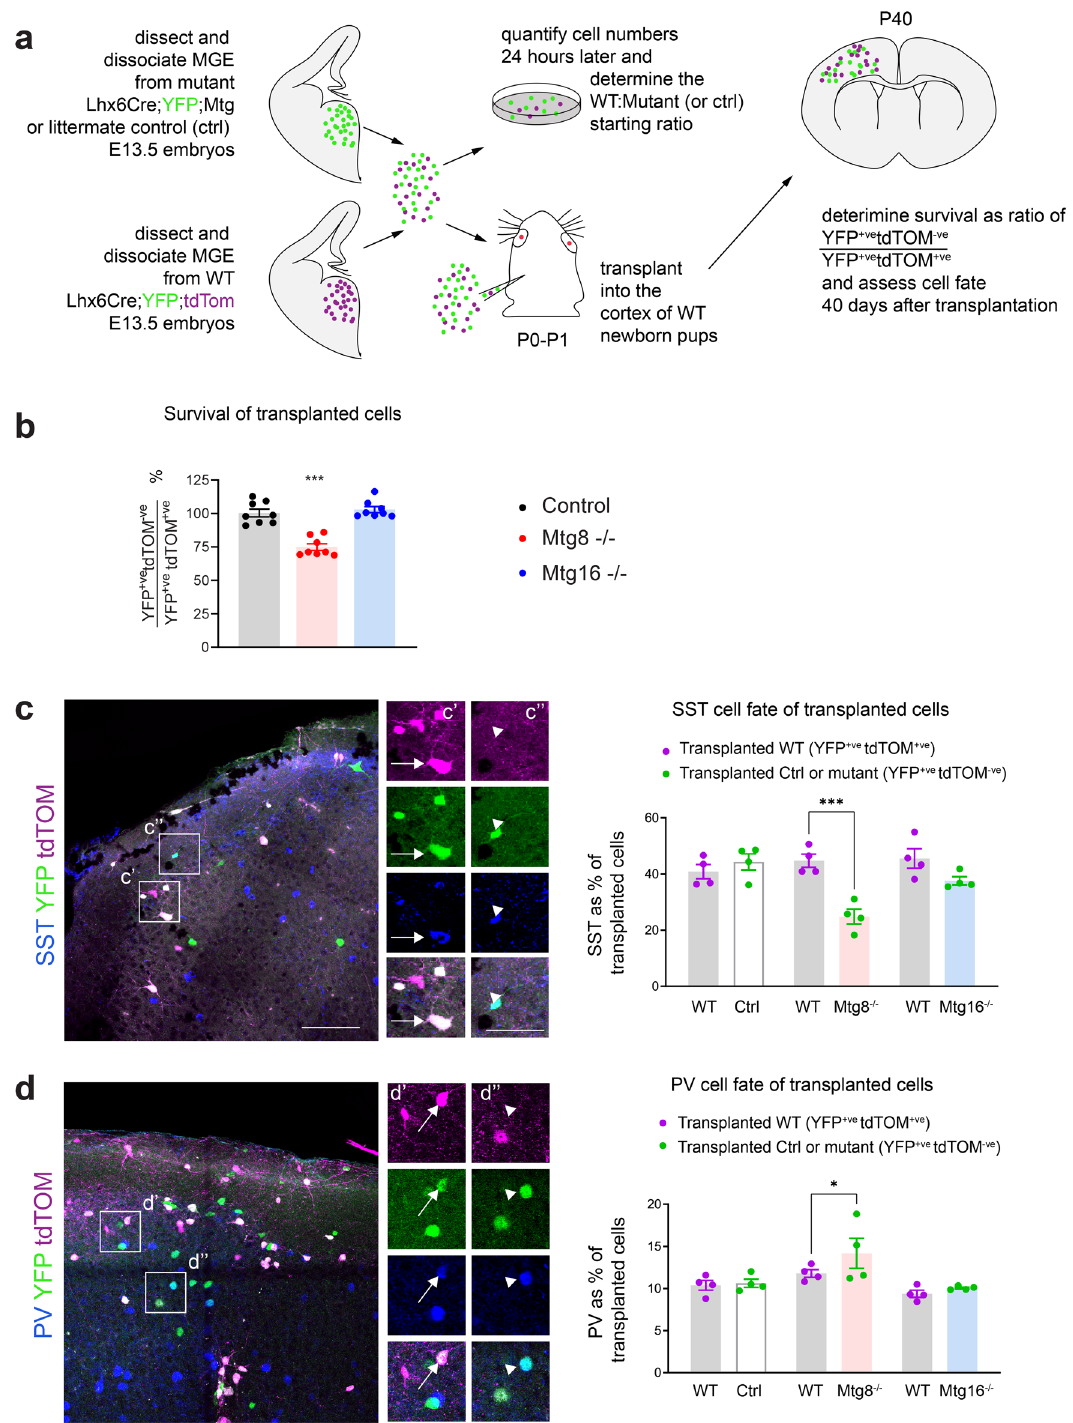
c , d Immunohistochemistry for SST ( c ) or PV ( d ) and tdTOM/YFP to detect transplanted control and mutant MGE precursors differentiating into SST or PV interneurons and quanti fi cation. n =4 brains per genotype. Two-way ANOVA followed by Uncorrected Fisher ’ s LSD tests. * P =0.0307, *** P <0.001. All graphs show mean±SEM. Source data are provided as a Source Data fi le. Scale bars: ( c , d ) 100 μ m and higher magni fi cation 50 μ